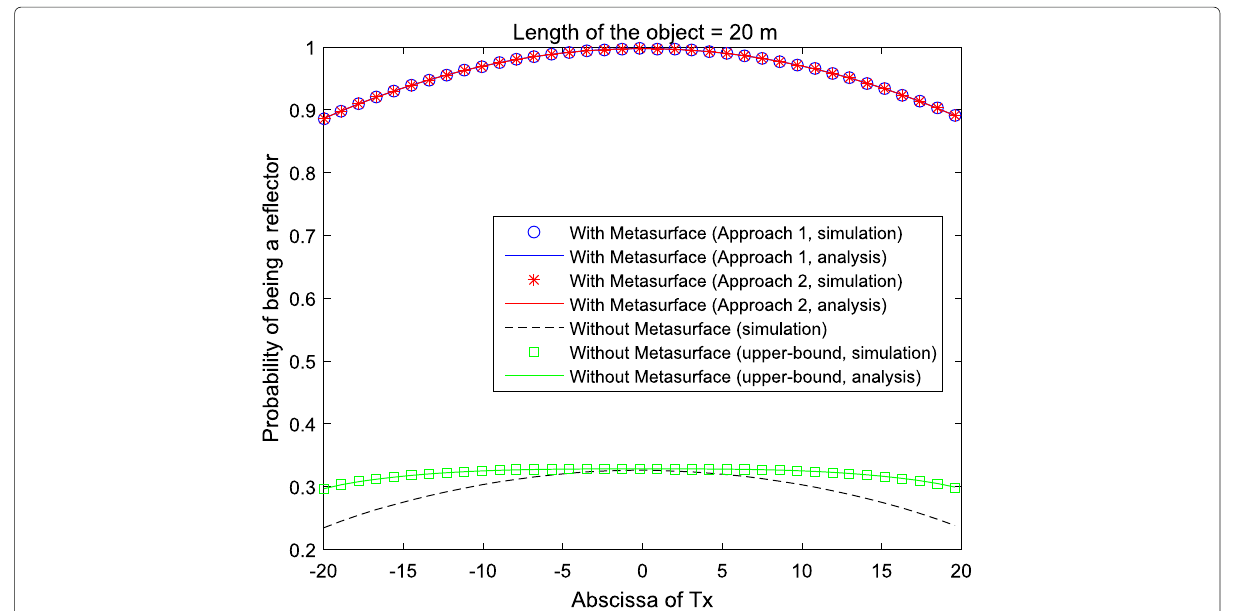
Fig. 9 Probability of being a reflector versus the horizontal location, x Tx , of the transmitter. Setup: R net = 30 m, vertical location of the transmitter y Tx = 3, location of the receiver ( 0,0 ) , length of the object L = 20